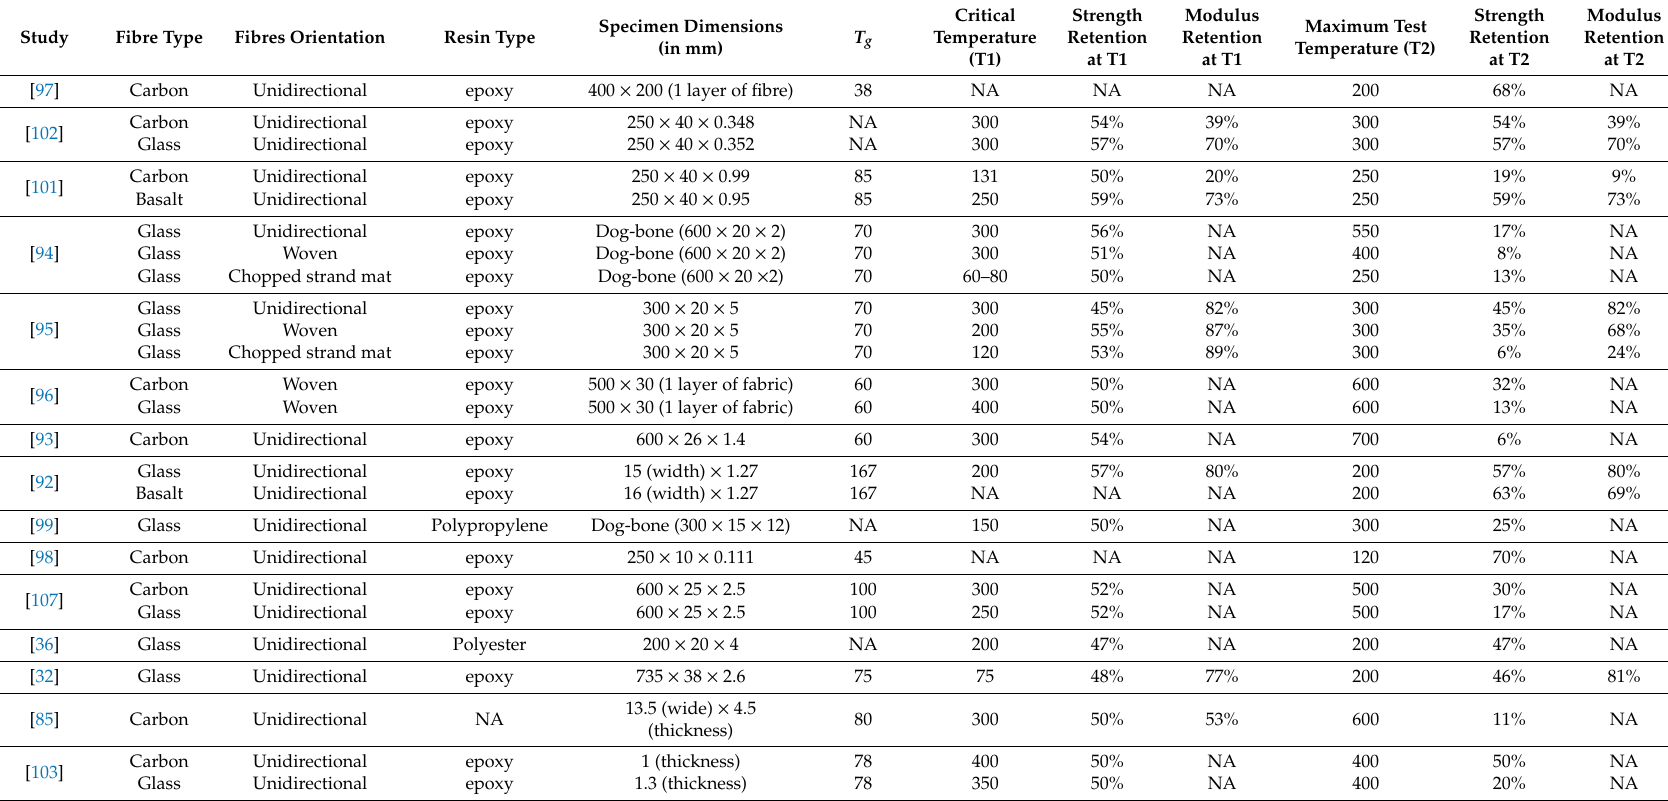
Table 3. FRP laminates / sheets tensile properties after exposure to elevated temperatures (steady state tensile